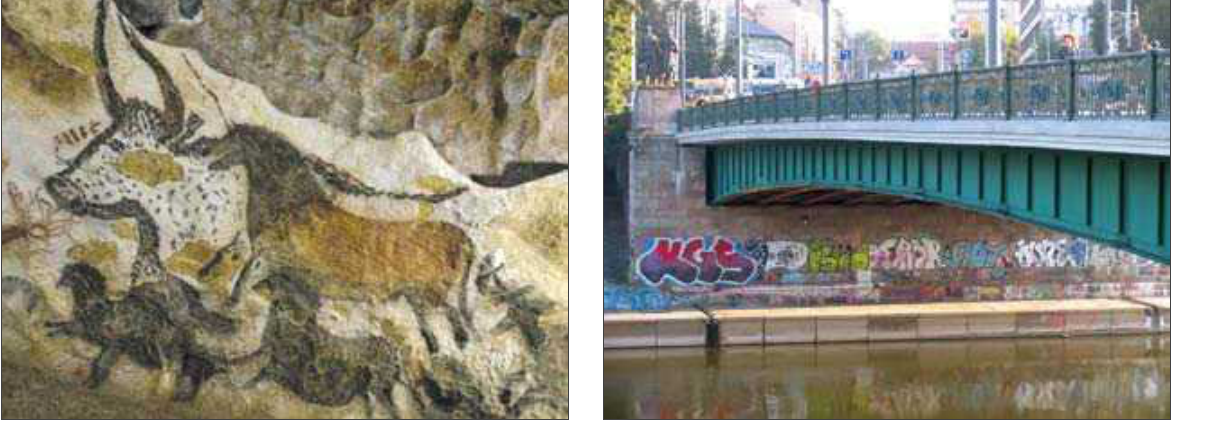
Fig. 3. Drawings in the cave Lasko (France)